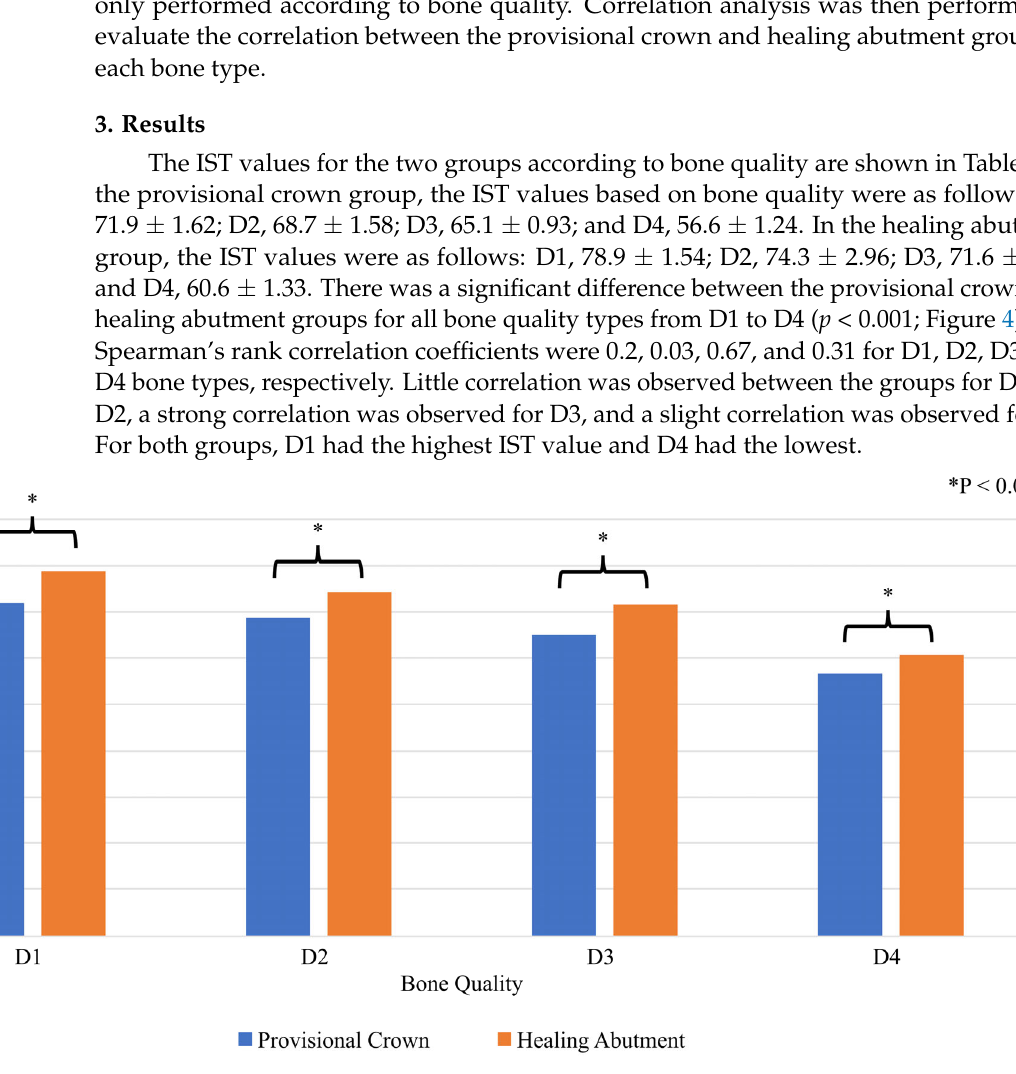
Figure 4. Comparison of the IST value of both groups by bone quality. IST: implant stability test.